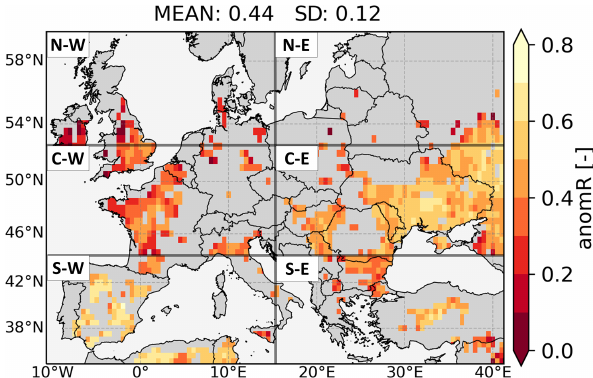
Figure A1. Anomaly correlation (anomR) between SIM1 AquaCrop SSM and SMOS SSM for the period 2011–2016. The spatial mean and standard deviation are indicated (MEAN and STDEV). The six European subregions used to describe the model evaluation and the future I net are indicated (from top left to bottom right in the northwest, northeast, central–west, central–east, south- west, and